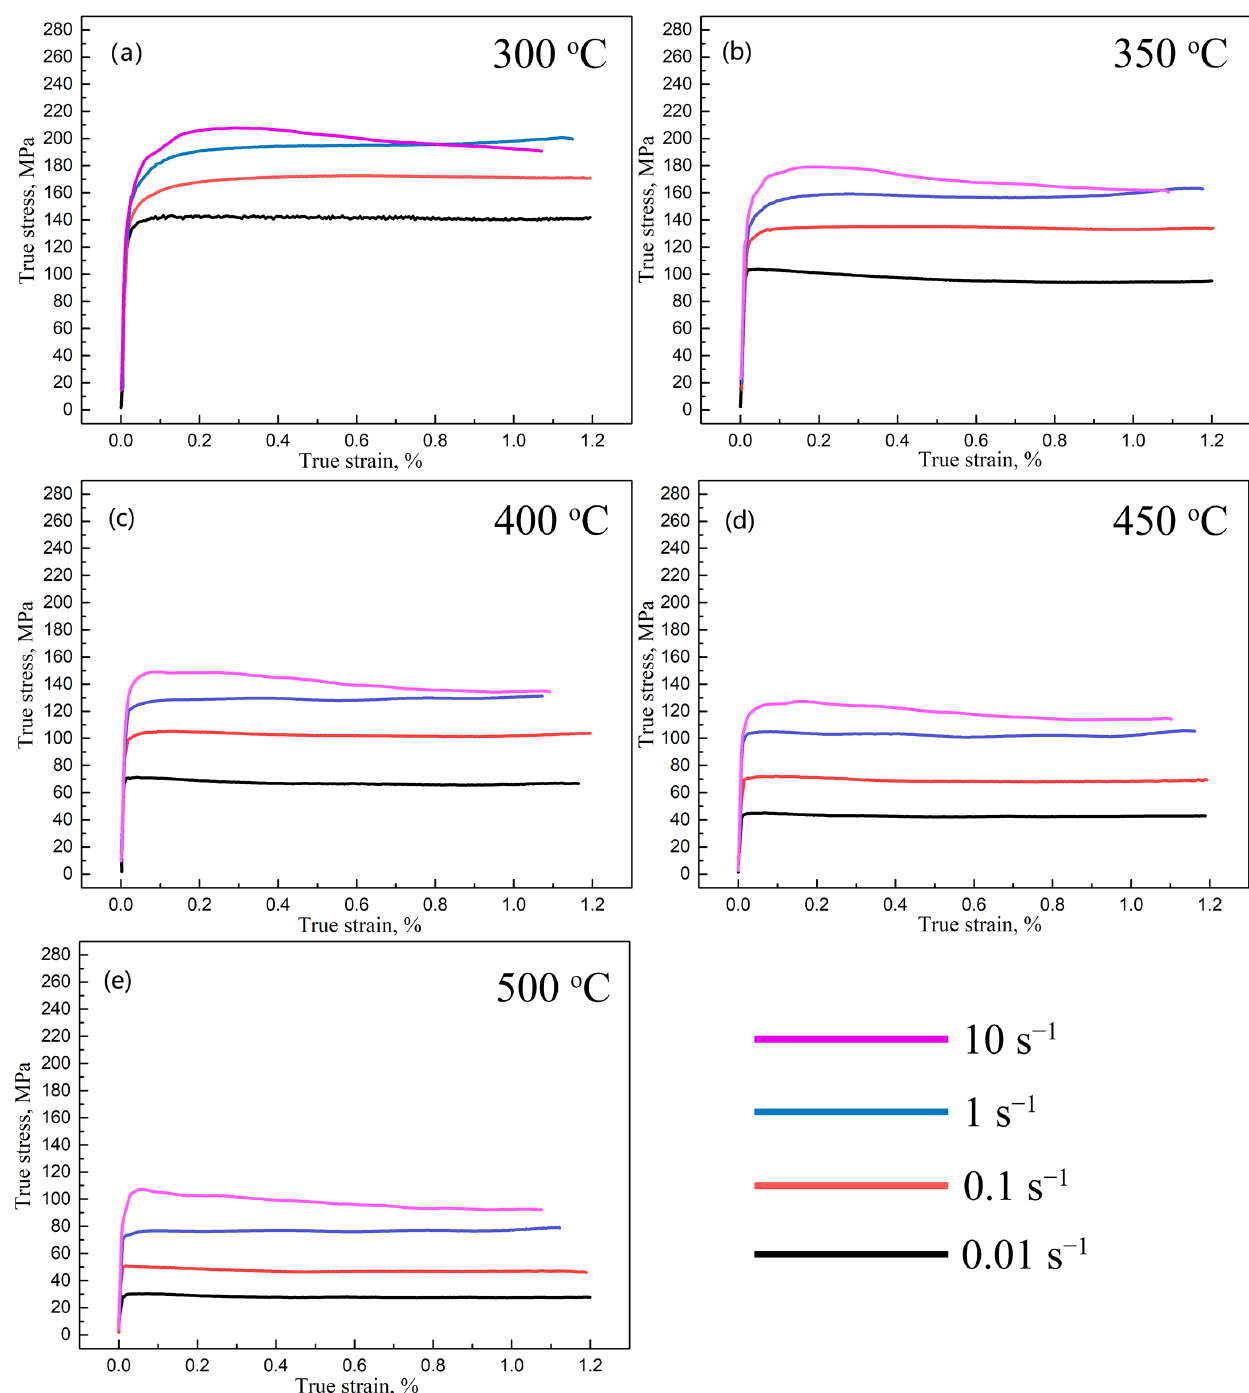
Figure 3. Hot compression true stress − strain curves of B alloy (5182 − 0.05Sc − 0.1Zr alloy) at ( a ) 300